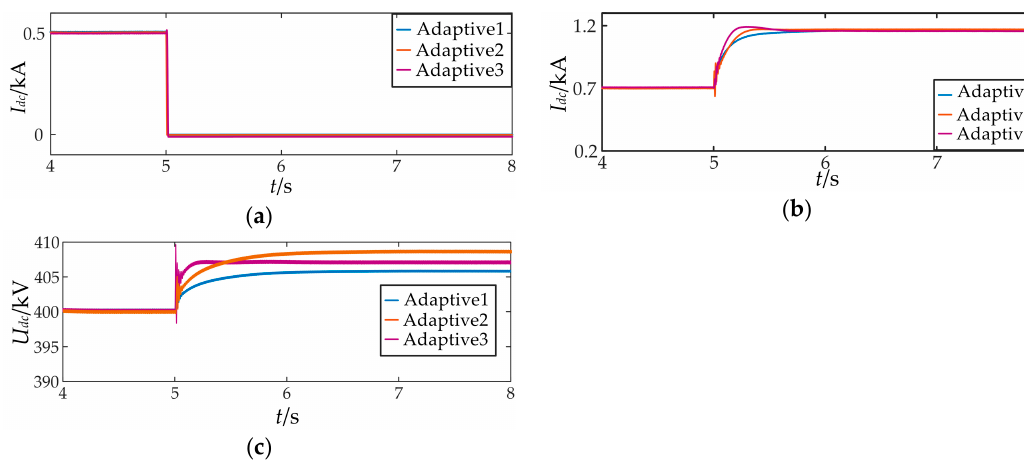
Figure 19 . Simulation waveforms of LCC3 being out of operation: ( a ) DC current of LCC3; ( b ) DC current of LCC4; ( c ) DC voltage. Where Adaptive1, Adaptive2, and Adaptive3 denote the adaptive droop control strategy proposed in this paper, the adaptive droop control based on DC voltage deviation, and the adaptive droop control based on the DC voltage deviation coefficient and power distribution coefficient,